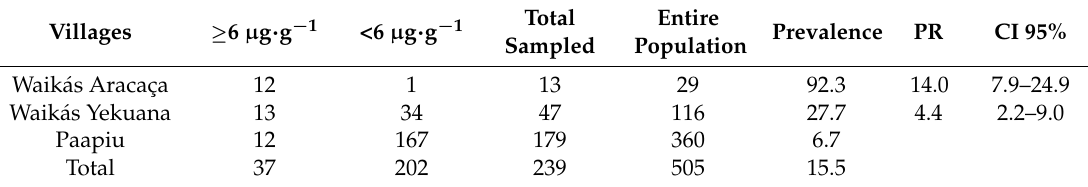
Table 1. Prevalence of mercury concentration, considering levels above 6.0 µ g · g − 1 , and Prevalence Ratio to illustrate a possible association between ASGM geographical location and mercury exposure, Yanomami reserve, Roraima, Amazon, Brazil, 2014.